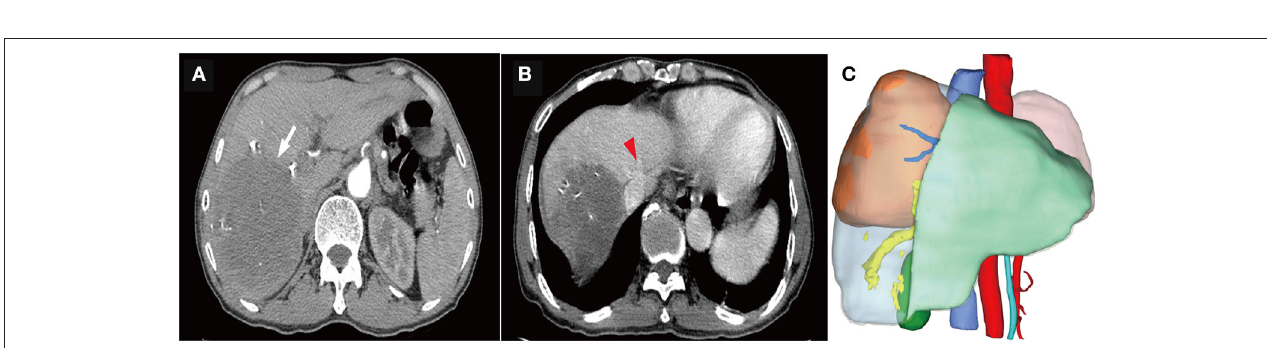
FIGURE 3 | Computed tomography (CT) scans and three-dimensional reconstruction after portal vein embolization (PVE) and multimodality therapy. (A) The tumor remarkably regressed (the white arrow), with complete disappearance of intratumoral enhancement on the artery phase. (B) The distance between the tumor and the middle hepatic vein (the red arrow head) was significantly extended. (C) The ratio of future liver remnant (the light green area) to the standard liver volume (SLV) was 67.74%, which was well-tolerated for hepatectomy.